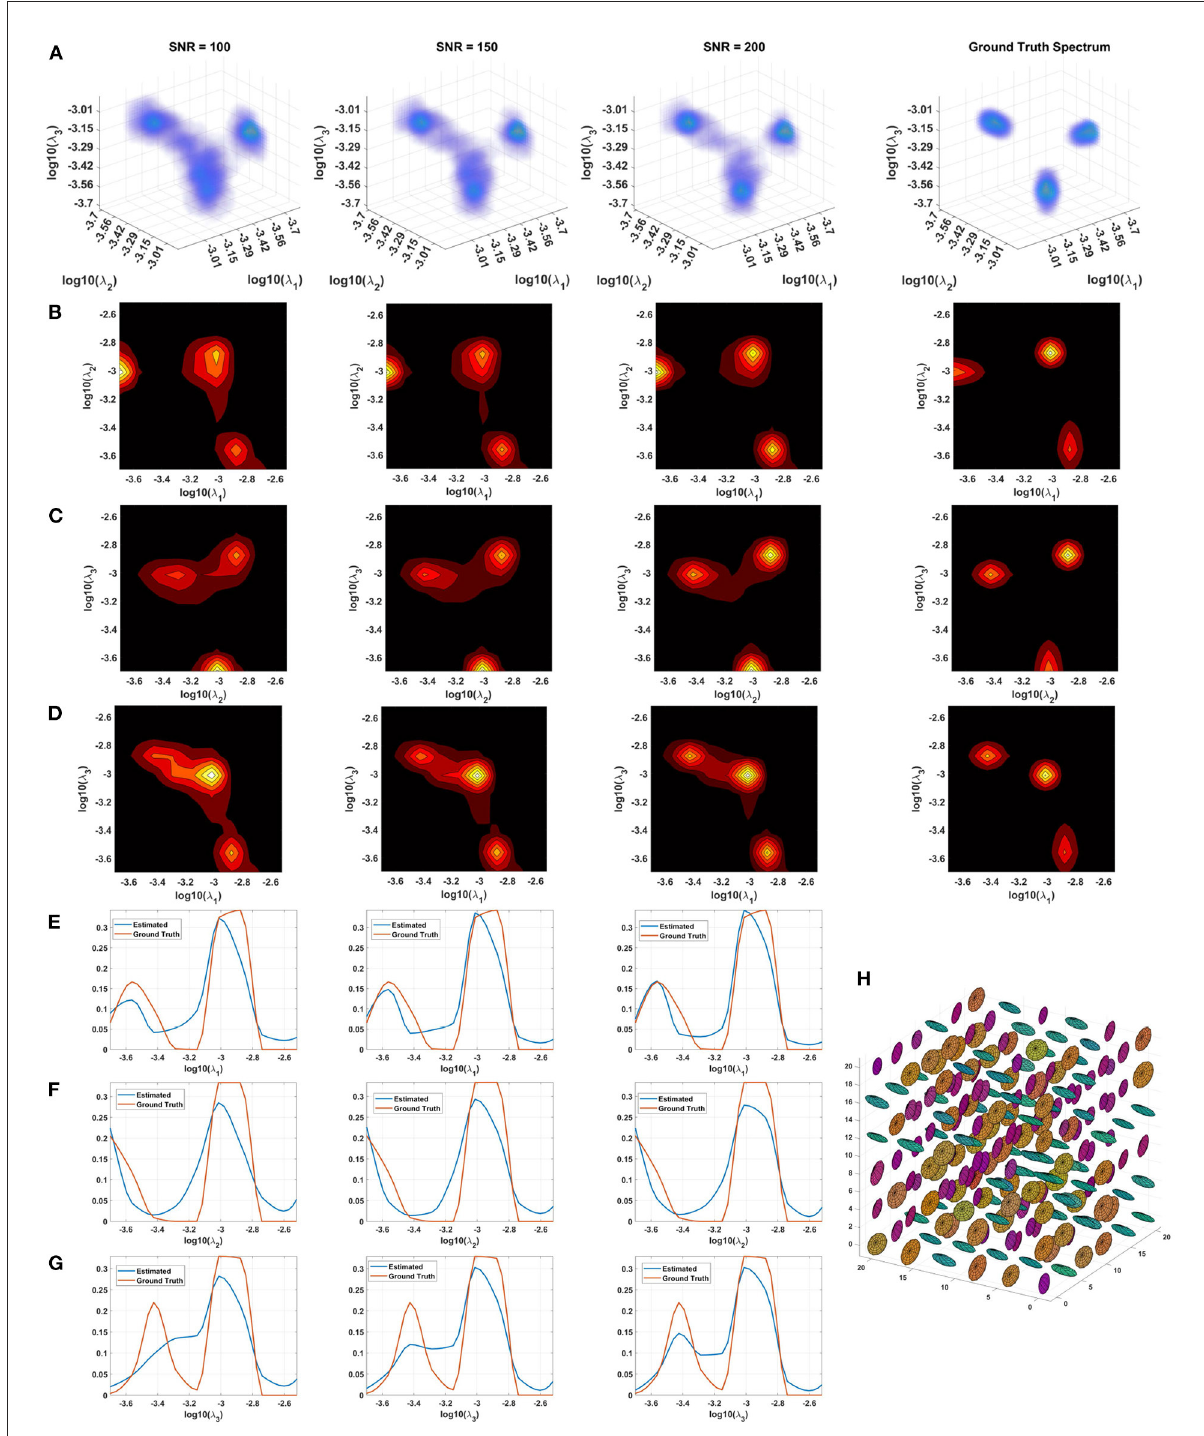
FIGURE3 Monte-Carlo simulation results illustrating the accuracy and numerical stability of the 3D cDTD reconstruction as a function of SNR. (A) : Log-log-log plots of mean normalized 3D cDTD correlation spectra of the principal diffusivities reconstructed from data with different SNRs. (B–D) : Log-log plots of mean normalized 2D marginal distributions derived from the 3D cDTDs in the top row. (E–G) : Log plots of the mean normalized 1D marginal distributions derived from the 3D cDTDs in the top row. (H) : A numerically simulated illustration of an ensemble of diffusion tensors described by the ground truth 3D